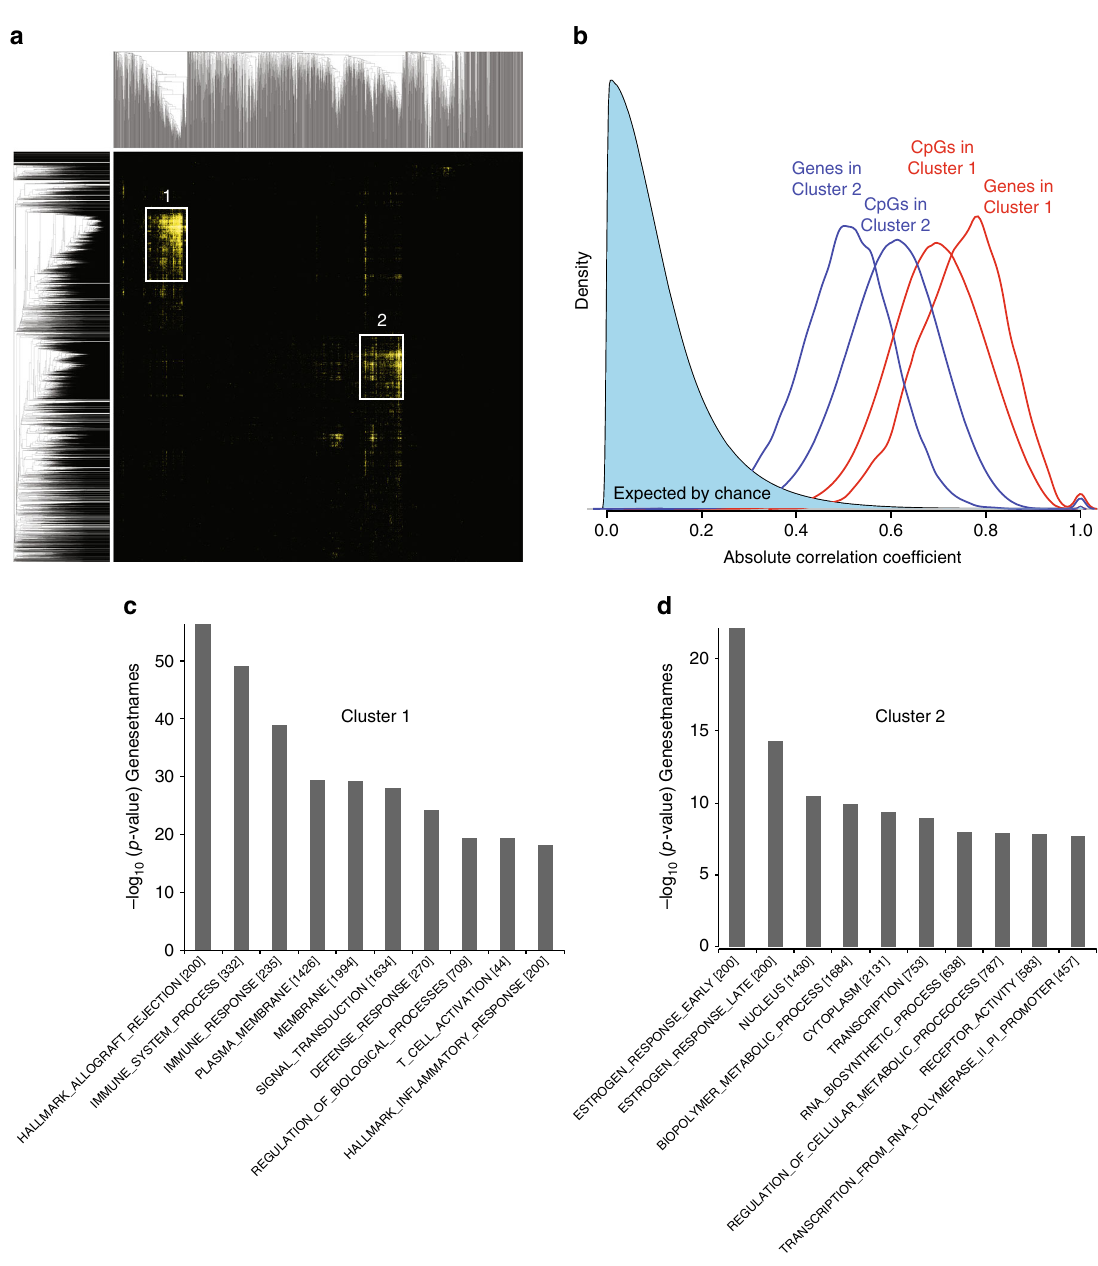
Fig. 1 Identi fi cation of expression-methylation QTL (emQTL) a Unsupervised clustering of ( − log) p -values of the emQTL by Pearson ’ s correlation and average linkage revealed two main clusters of CpG-gene pairs. Rows represent CpGs and columns represents genes. Yellow and light yellow spots show highly signi fi cant associations between CpG methylation and gene expression. b Density plot showing the degree of absolute co-expression of genes and co-methylation of CpGs in Cluster 1 ( red ) and Cluster 2 ( blue ). c , d Gene set enrichment analysis in Cluster 1 ( c , n = 160) and Cluster 2 ( d , n = 270) using MSigDB (H and C5 databases). The height of the bars represents the level of enrichment measured as a ratio between the number of genes overlapping an MSigDB H or C5 gene set over the expected frequency if such overlaps were to occur at